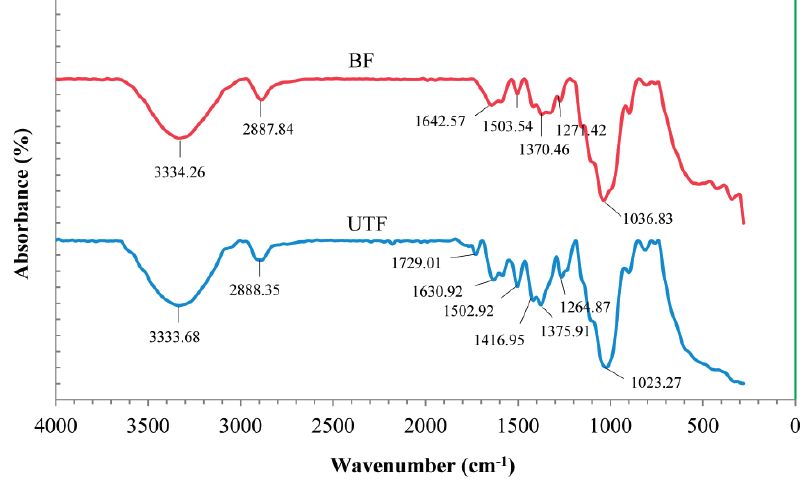
Figure 3. Fourier transform infrared (FTIR) spectra for untreated fiber (UTF) and bleached fiber